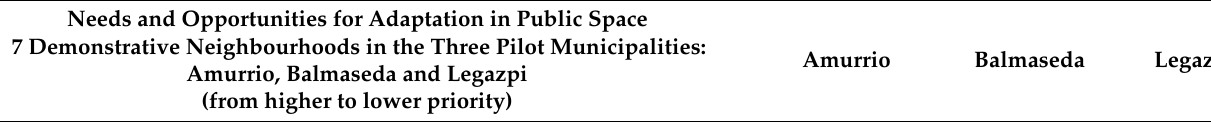
Table 2. Needs and opportunities in public space (developed by the authors).